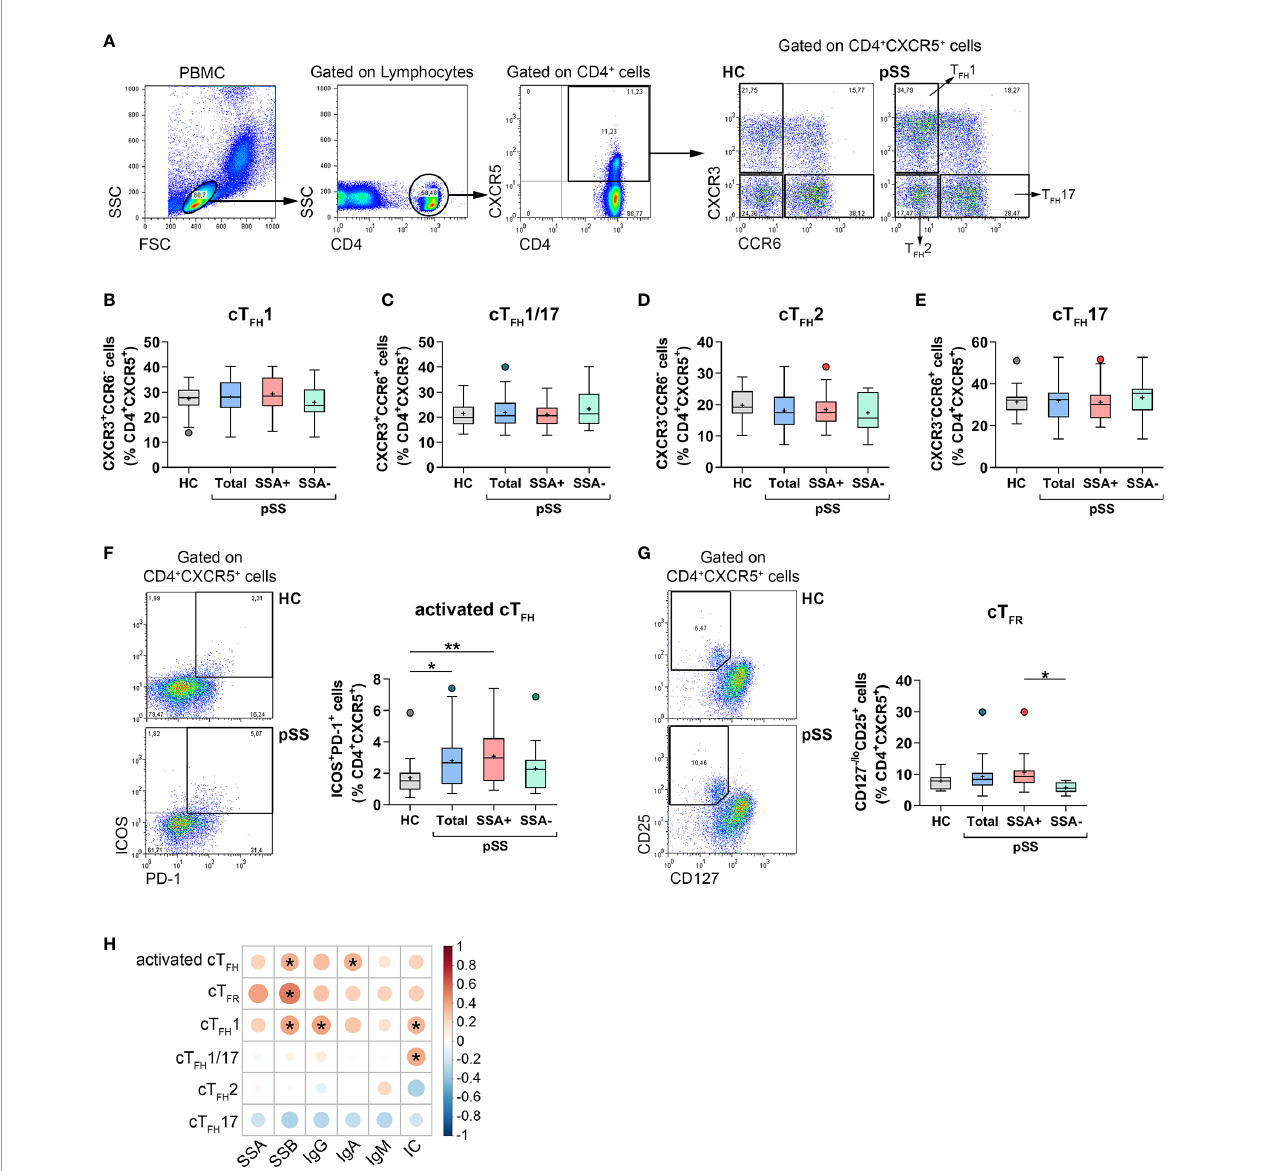
FIGURE 1 | The distribution of cT FH subsets and T FR cells in patients with pSS and their association with laboratory serological markers. PBMCs were isolated from 38 pSS patients and 29 healthy controls (HC) then were stained with fl uorochrome-labeled antibodies as described previously. Peripheral circulating (c)T FH subsets were quanti fi ed as their percentage within CD4 + CXCR5 + lymphocyte population. (A) Representative dot plots show the gating strategy and the division of T FH cell subpopulations. Percentages of cT (G) Representative dot plots display the gating of T FR cells in pSS and HC. Frequencies of T FR cells. (H) Correlation analysis of the percentages of T FH cell subsets and T FR cells with different serological parameters in patients with pSS. One-way ANOVA with Tukey ’ s multiple comparisons test (B, D, E) or Kruskal – Wallis test with Dunn ’ s multiple comparisons test (C, F, G) was used. Correlation analysis was performed using Spearman ’ s test (H) . Box plots represent the interquartile range (IQR) with a line in the middle as median and “ + ” sign as the mean value. Statistically signi fi cant differences are indicated by * p < 0.05; ** p <